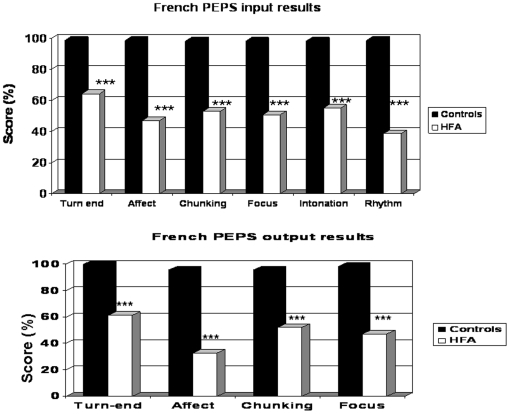
French PEPS input results.